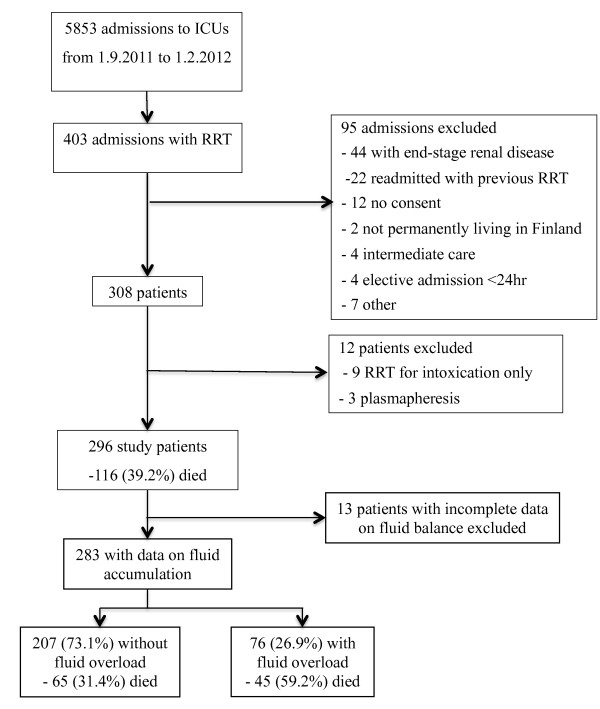
Study flow chart with 90-day mortality rates. *ICU, intensive care unit; RRT, renal replacement therapy.